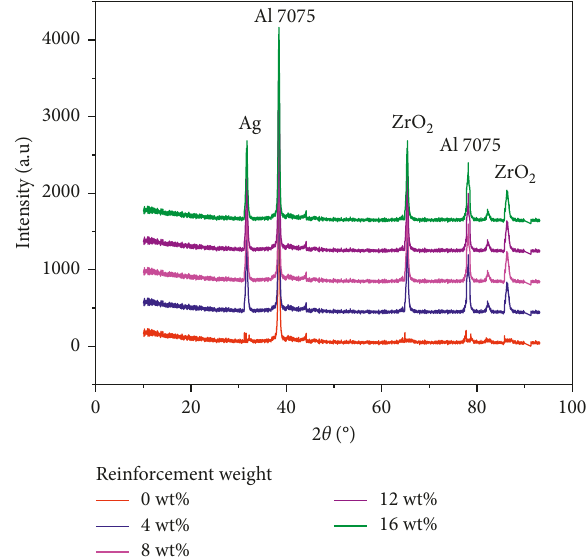
Figure 2: Tensile strength.